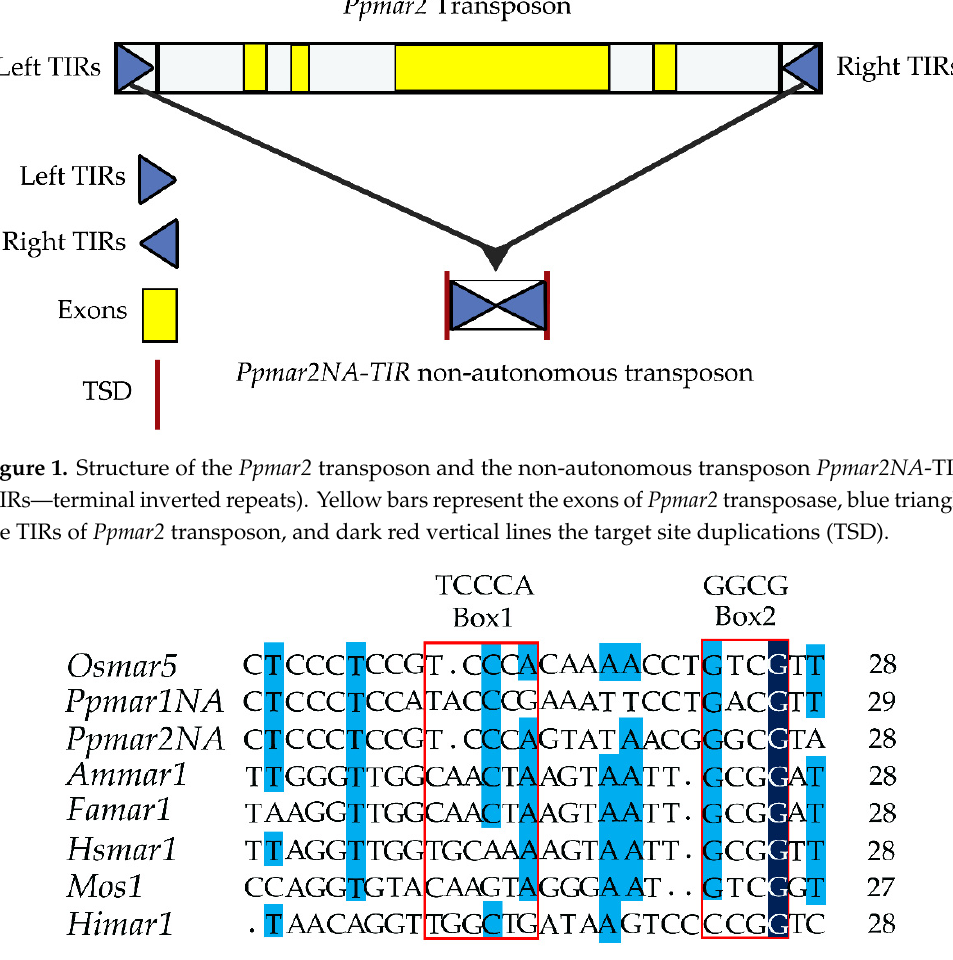
Figure 2. The alignment of TIRs of Mariner-like elements (MLEs). Osmar5 , AP008207 of Oryza sativa ; Ammar1 , U19902 of Apis mellifera ; Famar1 , AY226507 of Forficula auricularia ; Hsmar1 , U52077 of Homo sapiens ; Mos1 , X78906 of Drosophila mauritiana ; Himar1 , U11646 of Haematobia irritans . Table 1. The Ppmar2NA -TIRs and their sequences with mutations details. The mutated bases are marked by the red font. Bold and underlined sequences on the left and right within each TIR represent Box1 and Box2, respectively.